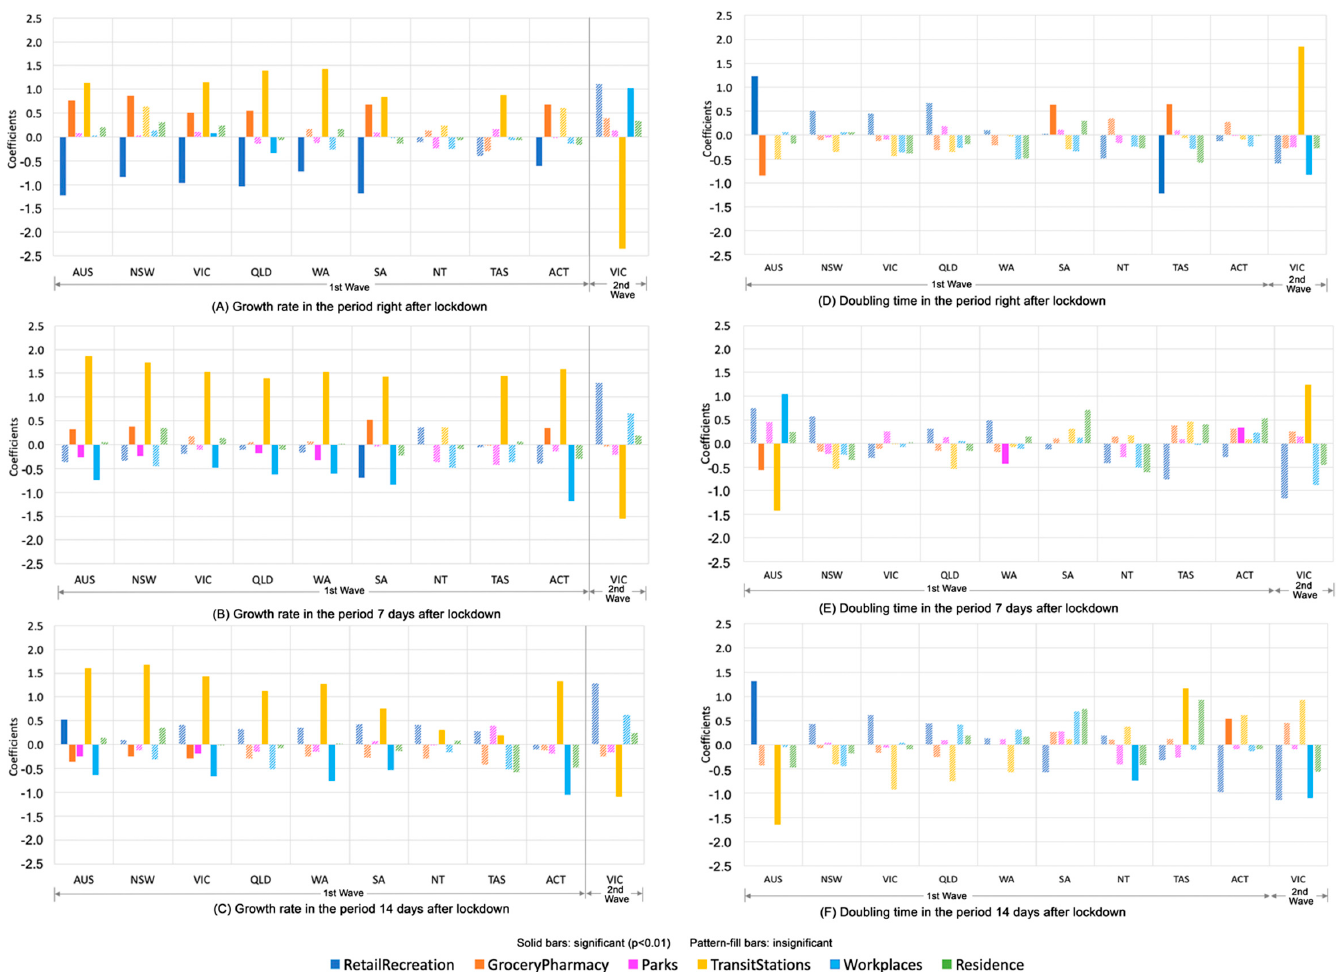
Figure 6. Regression coefficients of six types of mobility in Australia and each state/territory over three periods of time. Note: Regression coefficients are provided in Supplementary Materials.